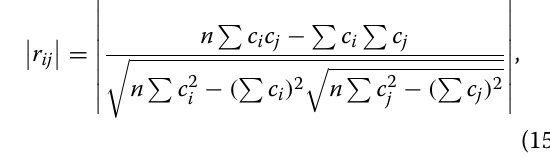
Table 1 Material parameters of 42CrMo cast steel